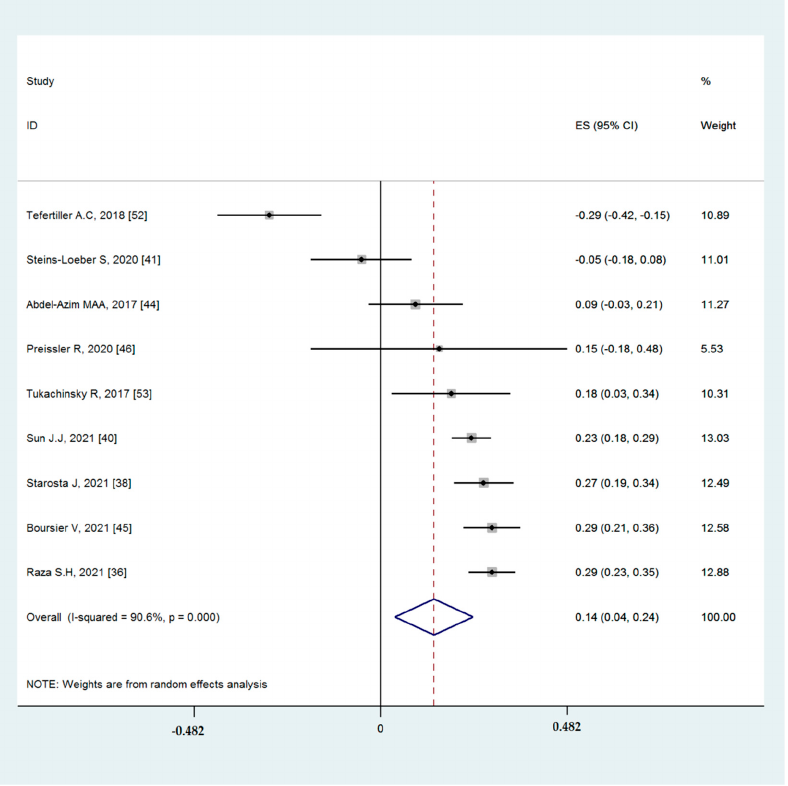
Figure 5. The sensitivity analysis plot assessing the small study effect in the estimated pooled Fisher’s z-score in the association between binge-watching and depression.